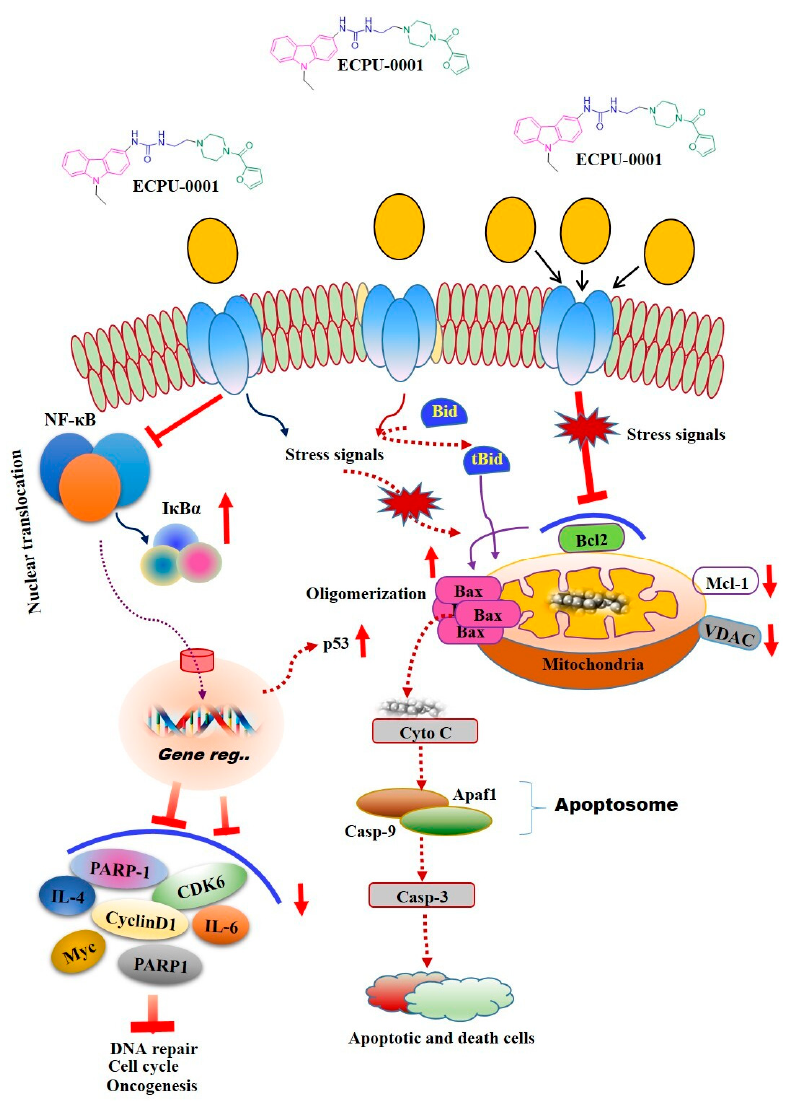
Figure 8. Proposed model for effects of ECPU-0001 in regulation of mitochondrial mediated apoptosis, NF- κ B pathway as well as tumorigenic immunomodulators IL-4 and IL-6. Schematic representation of ECPU-0001 efficacy and induction of mitochondrial mediated apoptosis pathway.